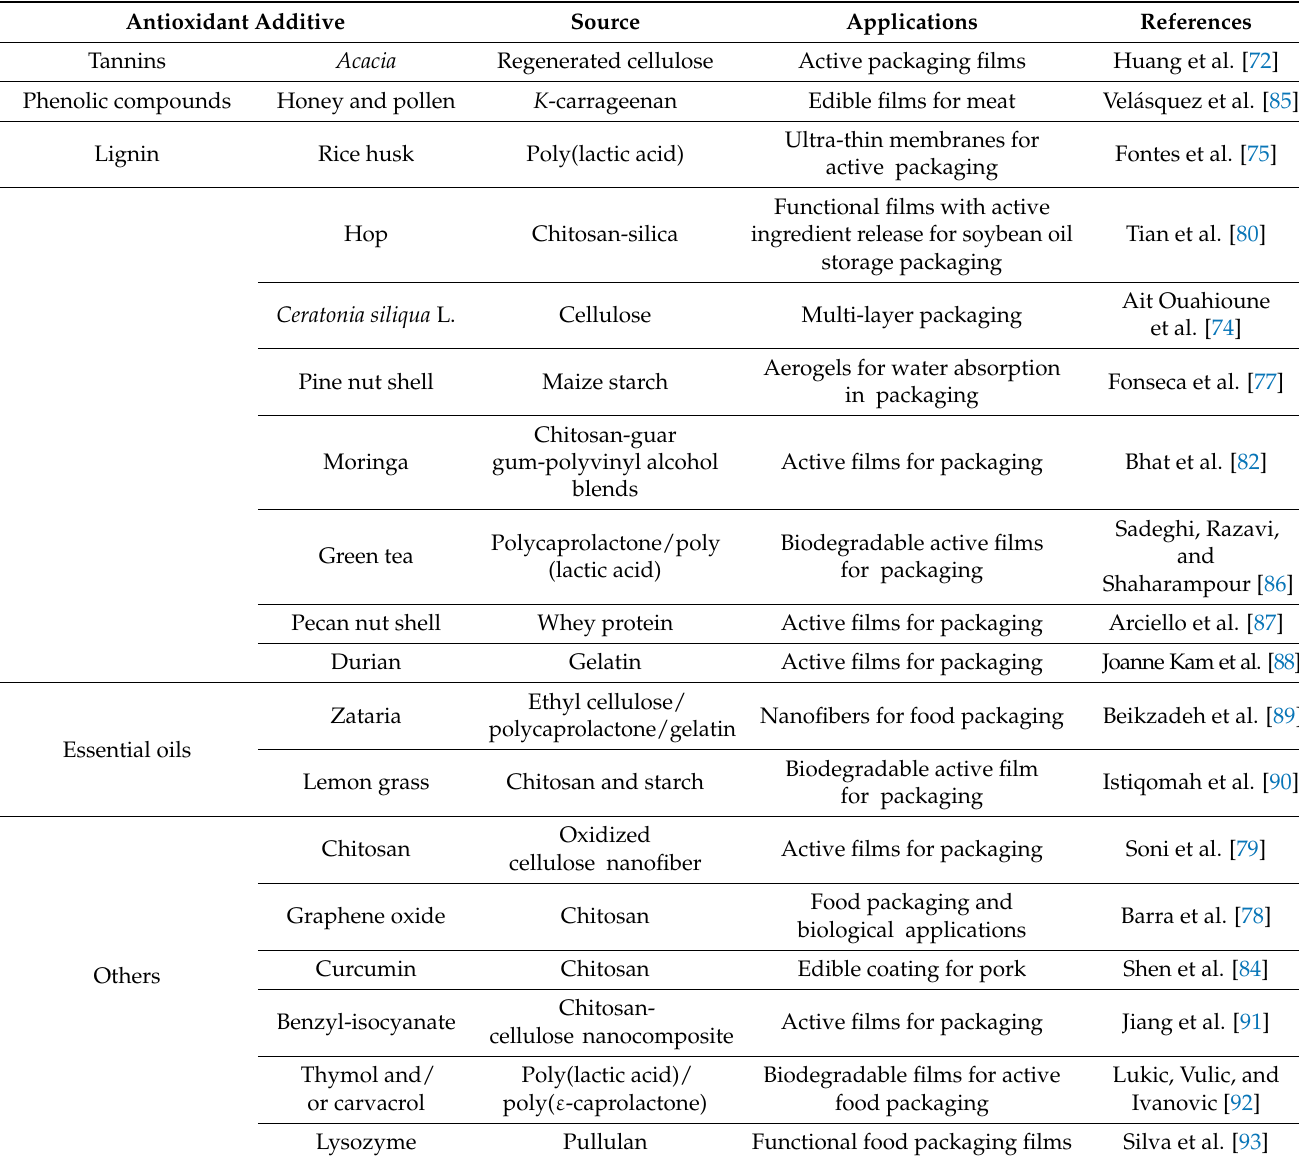
Table 2. Antioxidant biomaterials from different polymer matrices and their applications in the food